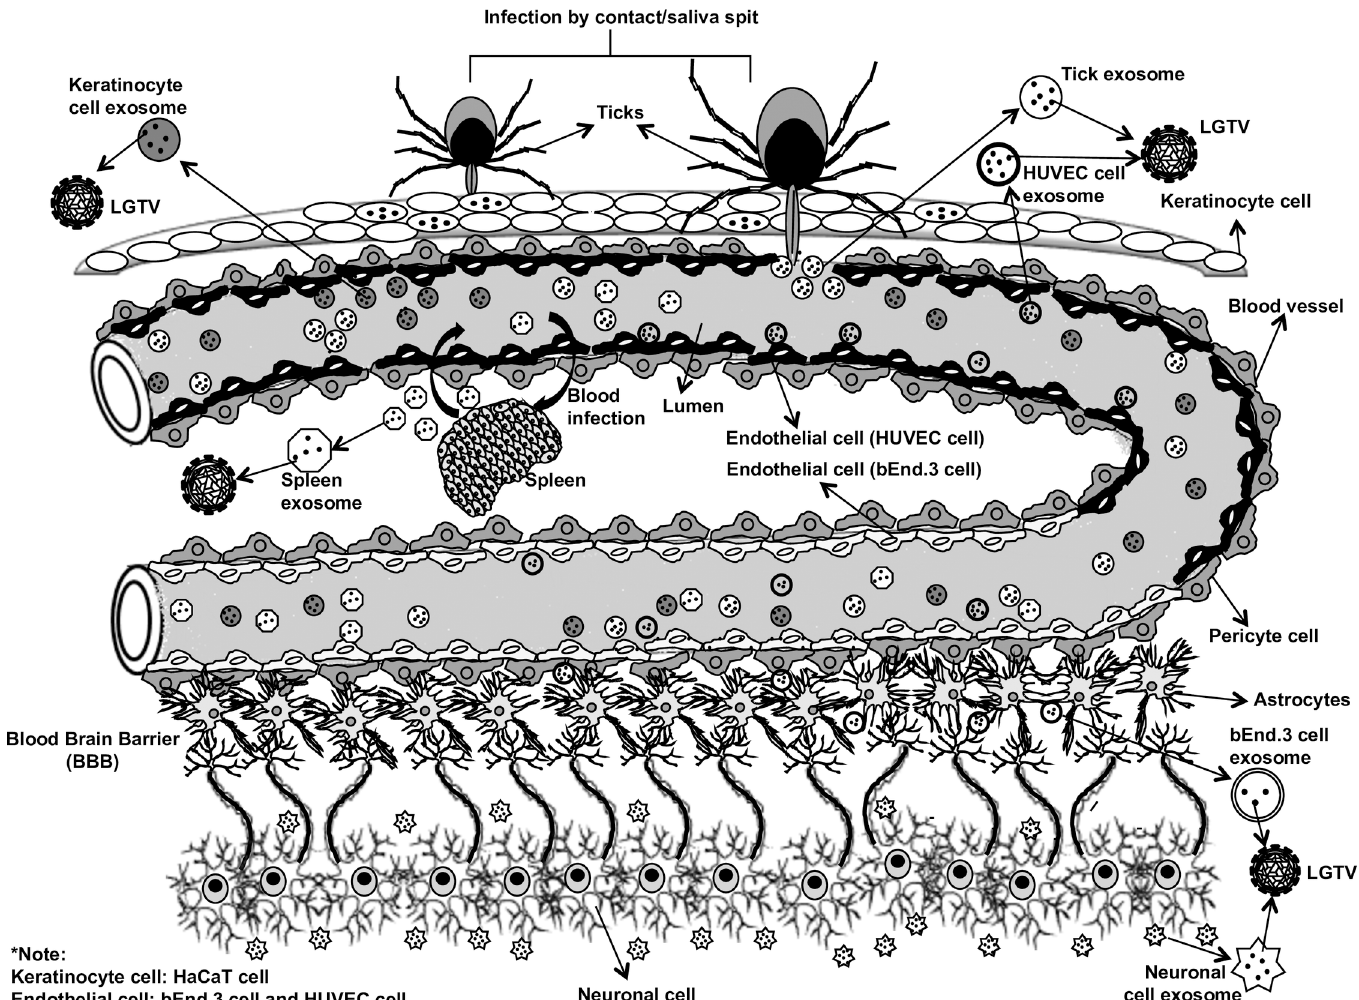
Fig 8. Proposed model showing arthropod-borne flaviviruses transmission to human host via arthropod exosomes. Tick bite or injection/spit of saliva from infected ticks depositsexosomescontainingviral infectiousRNA or proteinssecurely to humans. Exosomesderived from tick cells/saliva infect humanskin (keratinocytes) or may directly depositsaliva enrichedwith exosome containingtick-borne viruses into the blood capillaries/vessels. Exosomes derived from vascular endothelialcells containingflavivirusesinfect neighboring endothelial cells leadinginto infectionof the peripheral system. Higher viral loads in peripheral tissues increaseviremia in bloodand eventuallyallow entry and replicationof these arthropod-borne viruses in brain microvascular endothelialcells that line the BBB. Early production and higherloads of flavivirusesin brain endothelial cells wouldallow these viruses to cross BBB and infect neurons.Infected neuronsproducehigh numbers of exosomes containing infectiousRNA and proteins that fuse with cell membranes of na ï veneuronalcells thereby infectingneighboring neuronsand leadingto spread of infectionand severe neuronalloss. bovine brain extract and 20% FBS) kindly provided by Dr. Catravas laboratory. To determine infection kinetics, 1 x 10 5 cells were seeded in a 12-well plate, infected with various multiplica- tion of infections (MOI 1; tick cells), (MOI 6: Vero, HaCaT, HUVEC, bEnd.3 and N2a cells) of LGTV. Wild type LGTV (LGT-TP21) strain used in this study was obtained from Dr. Alexan- der G. Pletnev, NIAID, NIH. Cells were collected at different time points (24, 48, and 72 or 96 and 120 h post infection, p.i.) and processed for RNA or protein extractions. Details for infec- tion studies corresponding to the data shown in different figures is mentioned in their respec- tive Figure legends. Briefly, for infection experiments (or re-infection studies) with exosome fractions containing infectious LGTV RNA and proteins, we infected 1 x 10 5 HaCaT/HUVEC